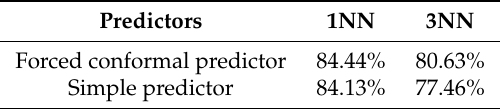
Table 4. Comparison of average classification rate of forced conformal predictors and simple